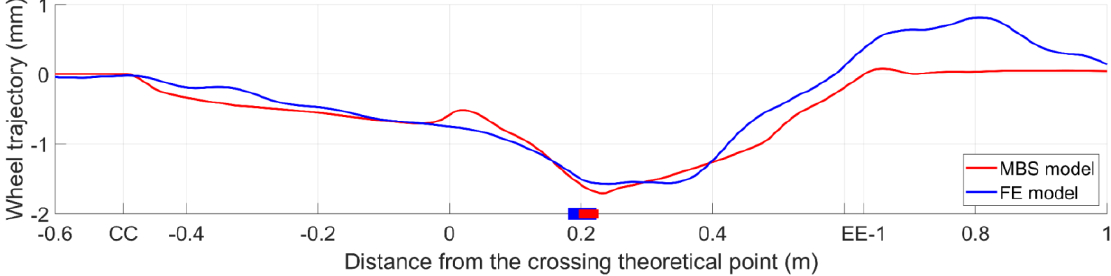
Figure 18. Wheel vertical trajectory comparison.